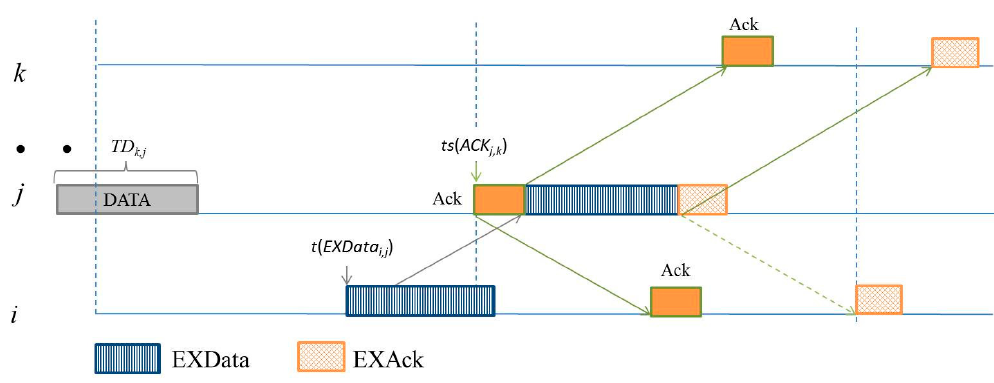
Figure 5. Sensor i transmits EXData to sensor j.